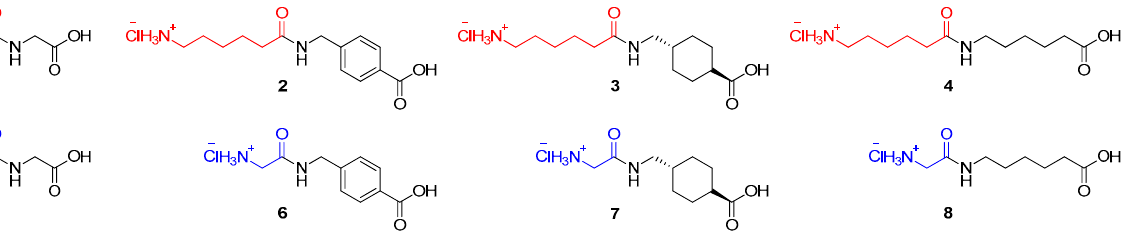
Figure 4. Structures of dipeptides 1 – 8 with expected hemostatic